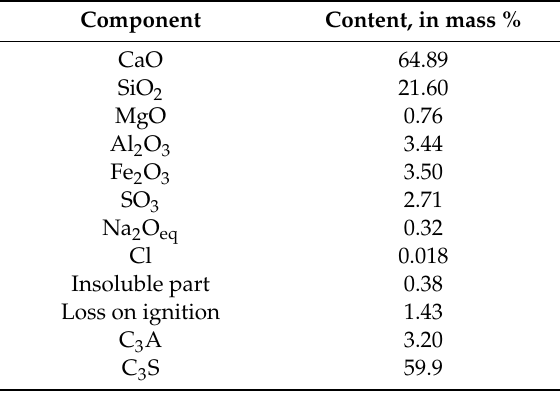
Table 1. Chemical composition of cement.